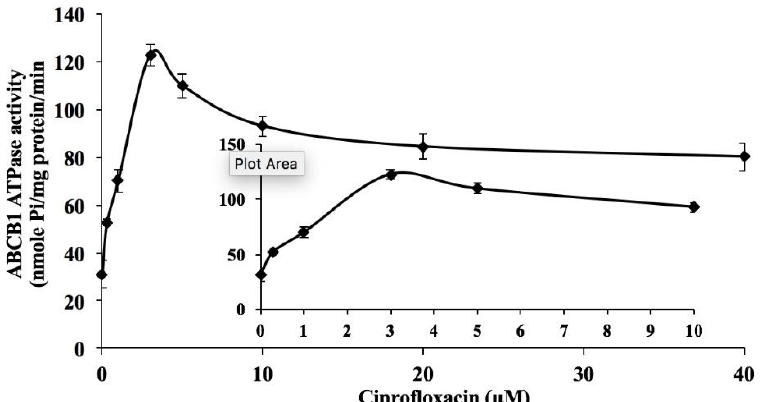
Figure 5. Effect of ciprofloxacin on orthovanadate (Vi)-sensitive ABCB1 ATPase activity. Crude membranes (10 µ g protein/reaction) from High-five cells expressing ABCB1 were incubated with increasing concentrations of ciprofloxacin (0–40 µ M). The inset shows stimulation of ATP hydrolysis at concentration of 0–10 µ M ciprofloxacin. The mean values are plotted and error bars depict SD.